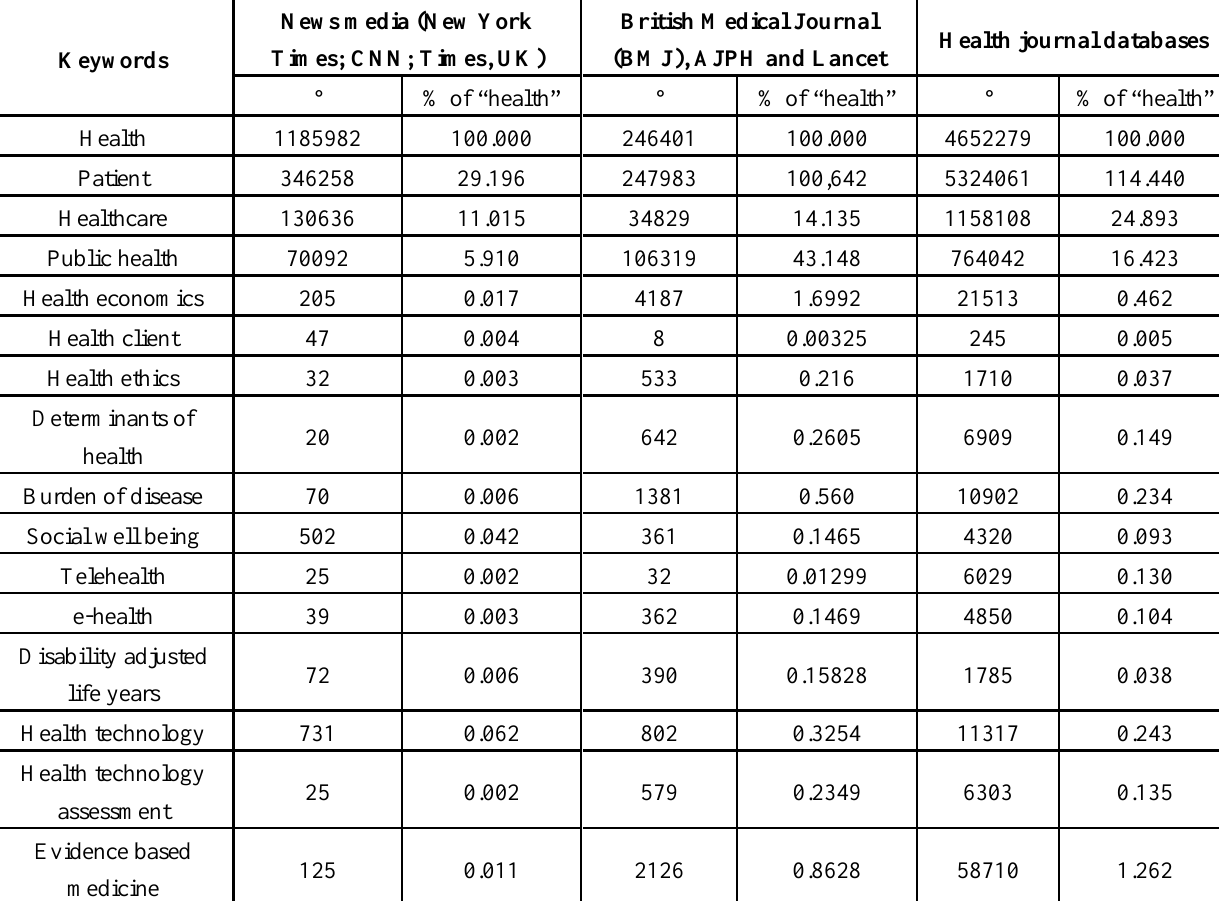
Table 1. Frequency of health policy terms covering different areas in different types of